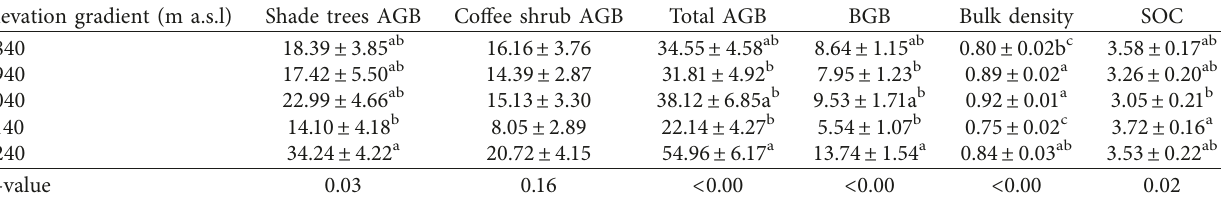
Table 5: Mean value of woody species AGB (Mg ha − 1 ), BGB (Mg ha − 1 ), soil bulk density (g cm − 3 ), and SOC % along an elevation gradient of coffee-based agroforestry